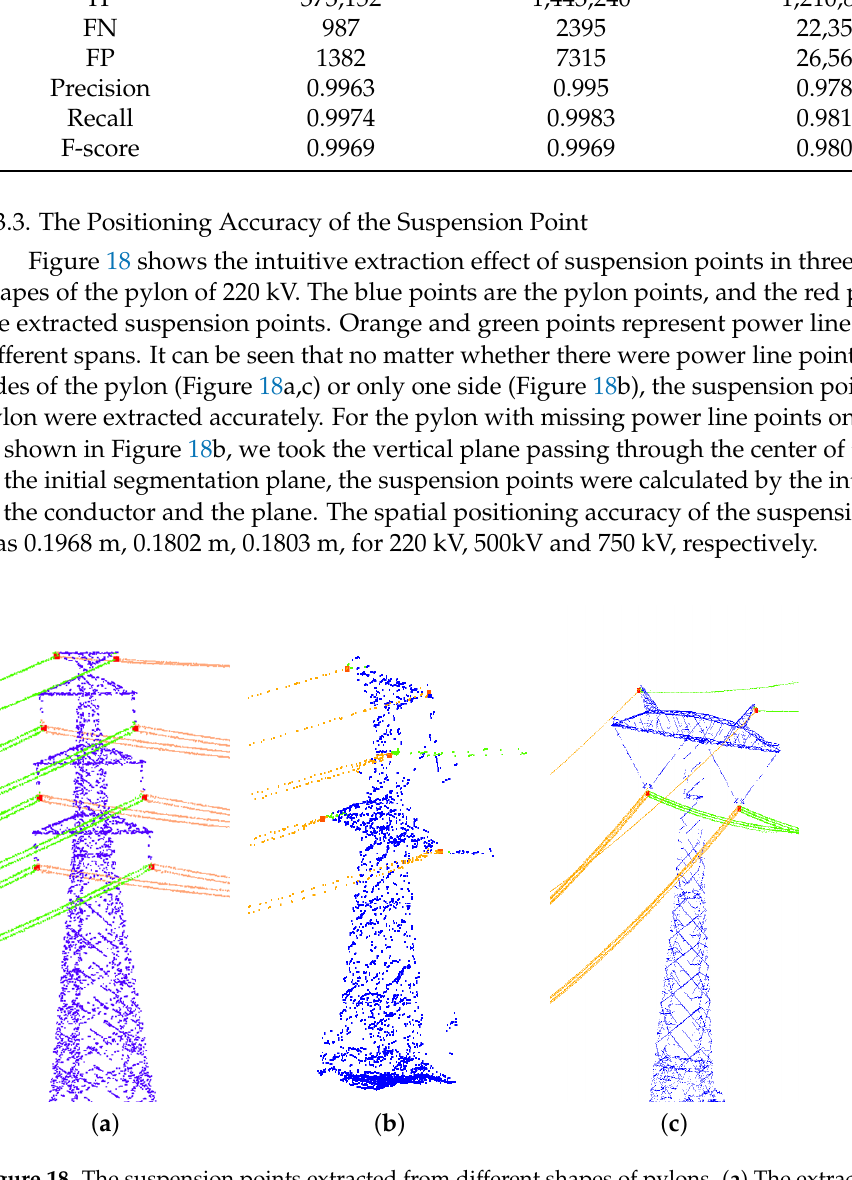
Figure 18. The suspension points extracted from different shapes of pylons. ( a ) The extraction result of suspension points at pylon connecting eight power lines. ( b ) The extraction result of suspension points at pylon with power line missing on one side. ( c ) The extraction result of suspension points at pylon connecting four power